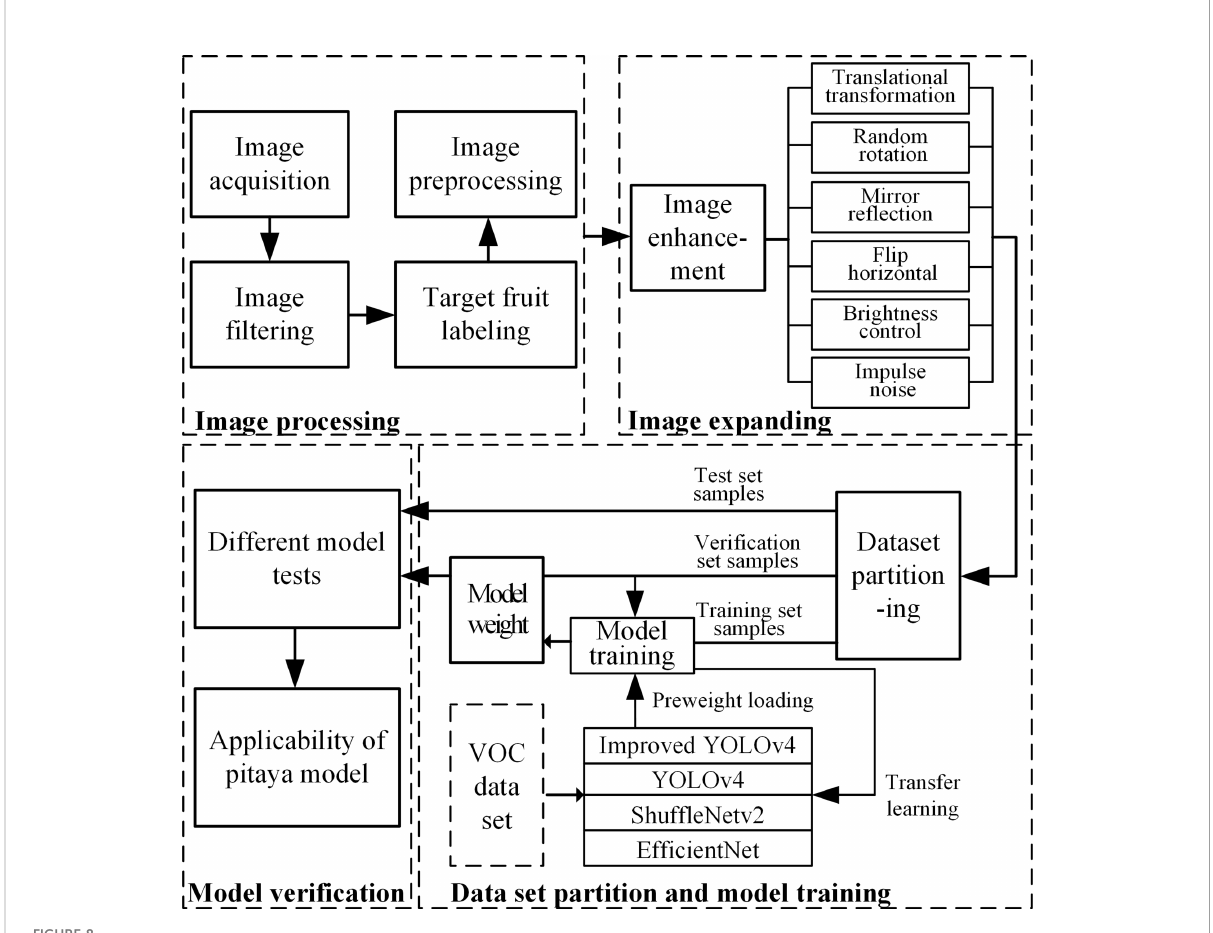
FIGURE 8 Flow chart of pitaya targets detection